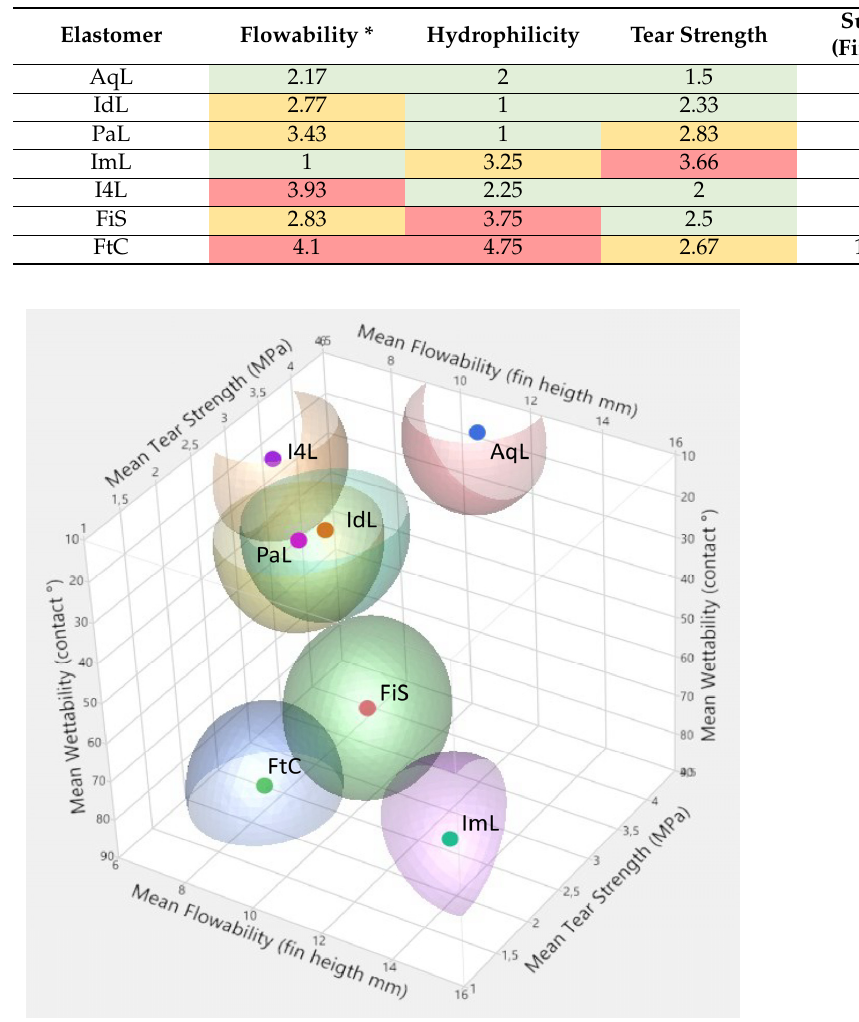
Figure 10. Data illustration that indicates how materials orient around the three tested properties: tear strength, flowability, and